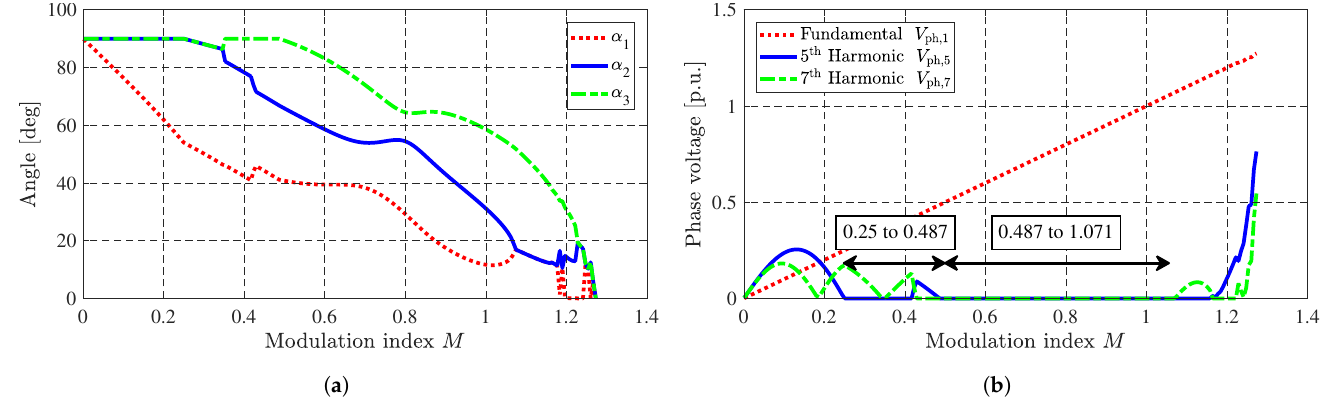
Figure 6. ( a ) Optimized pulse transition angles and ( b ) resulting output voltage components.